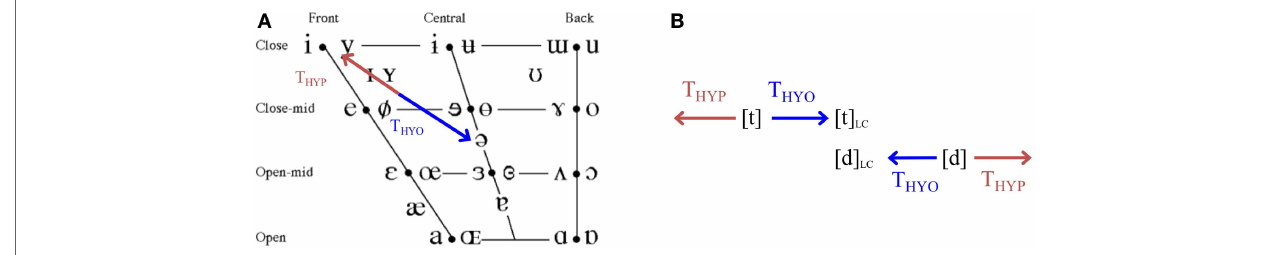
FIGURE 11 | Graphical representation of the transformations required to achieve hyper -articulated (red arrows, T HYP ) or hypo -articulated (blue arrows, T HYO ) output for (A) a vowel midway between [ ] and [ ] and (B) a pair of contrastive consonants [ ] and [ ] (LC signifies the minimum-contrastive